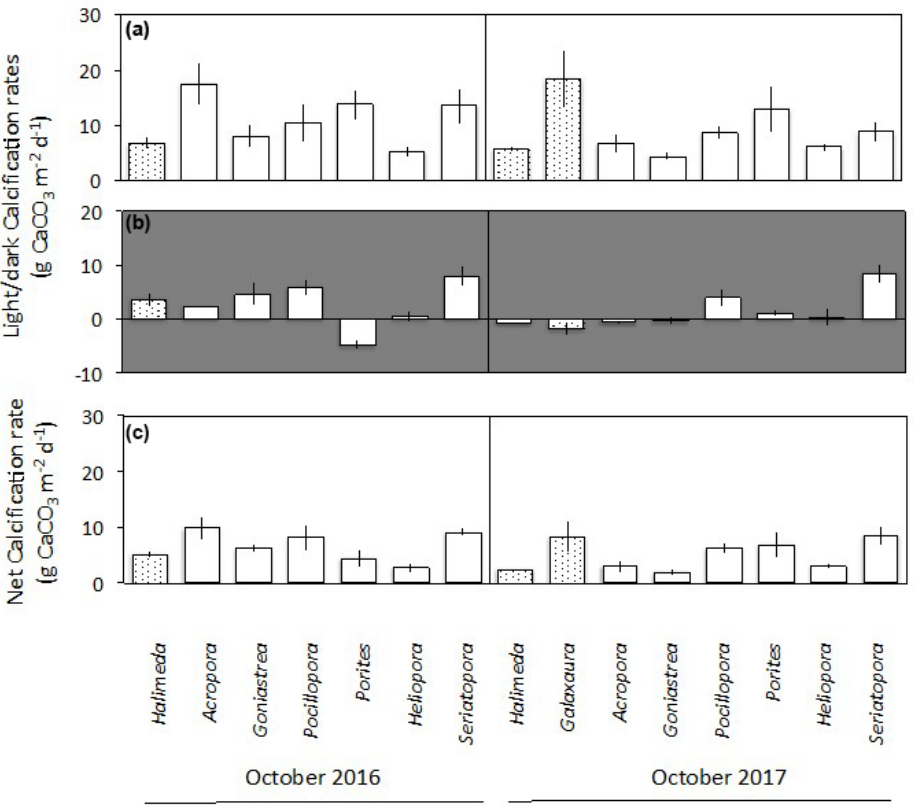
Figure 6. Calcification rates for corals (white) and calcifying algae (stippled) (mean ± SE) in light (a) and dark (b) incubations. Panel (c) shows the daily net calcification rate (mean ± SE), assuming a 12h